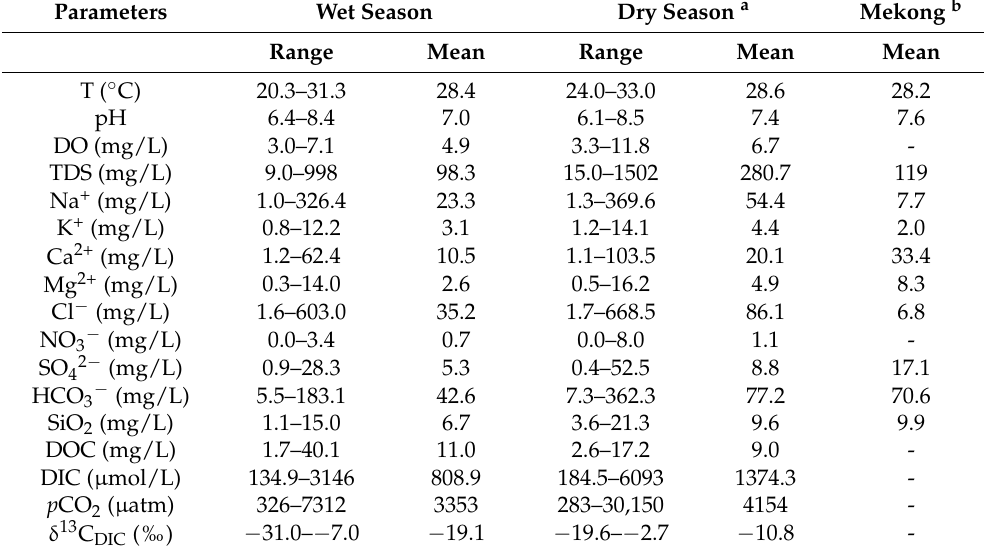
Table 1. A summary of the water chemistry and δ 13 C DIC values for the Mun